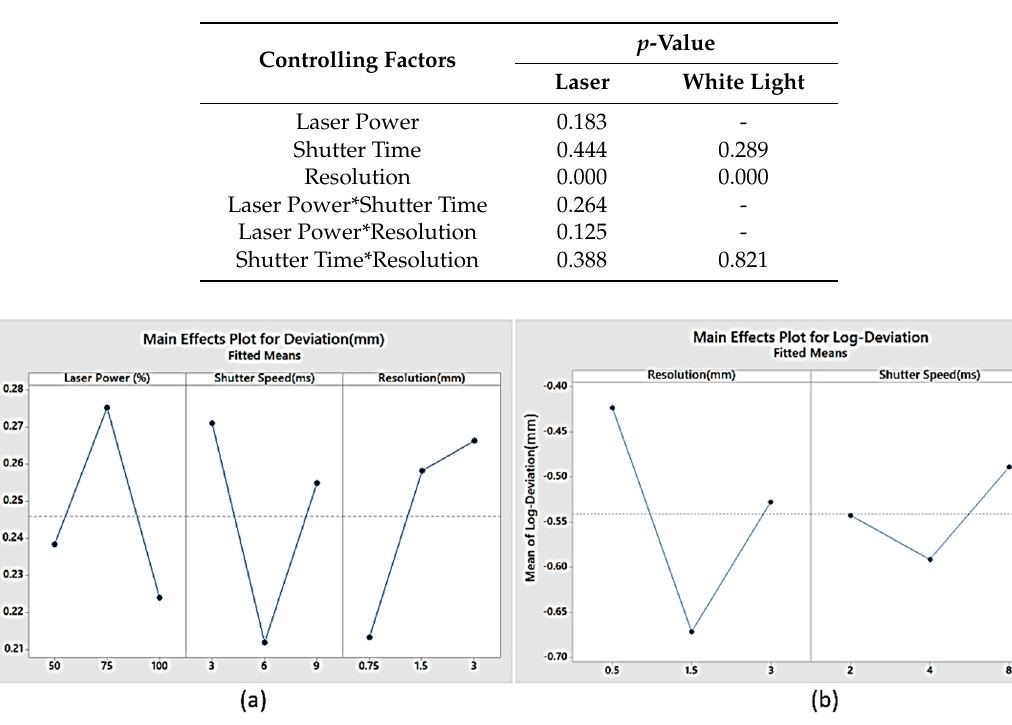
Table 6. p -Values using ANOVA for the laser-based and white light handheld scanners (triangle numbers).